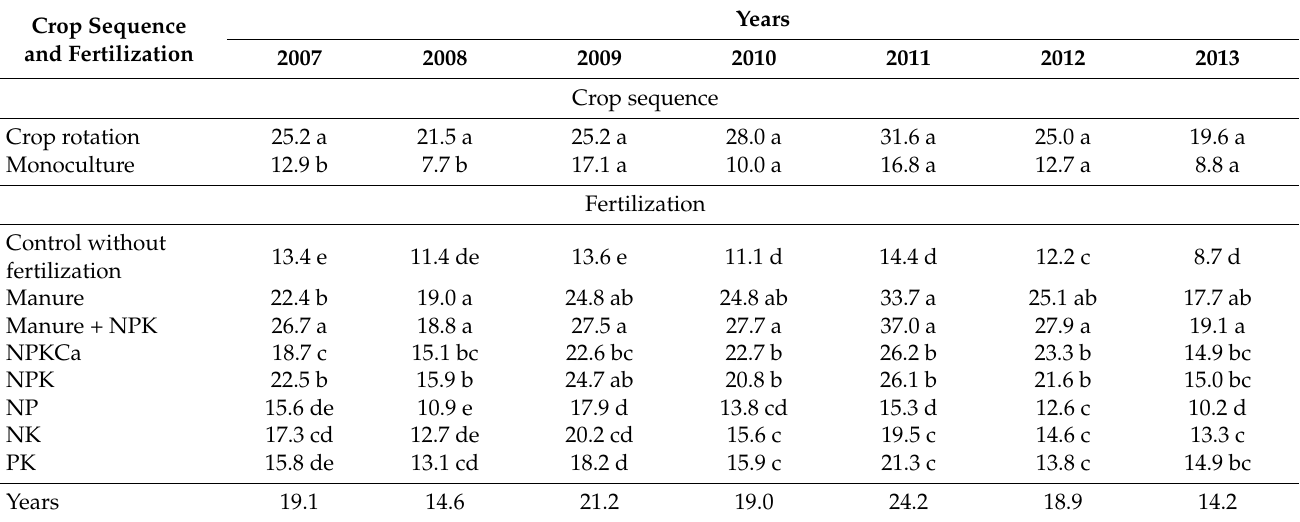
Table 2. Effect of cropping systems and fertilization on tuber yield of potato in years of research